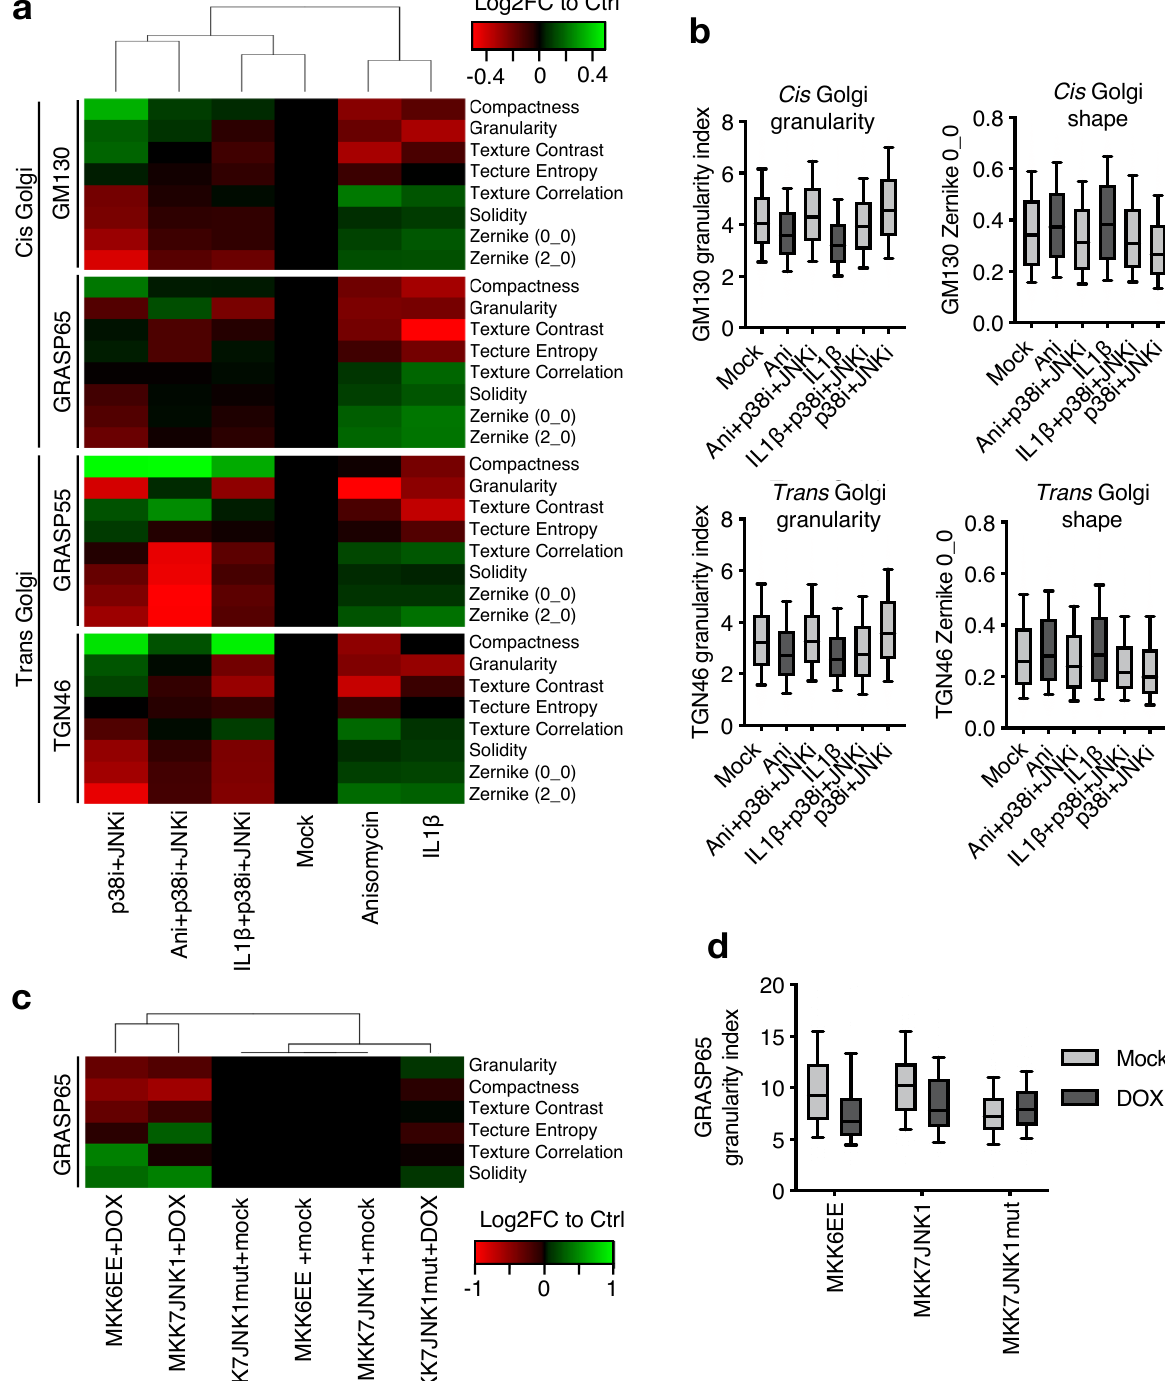
Figure 5. Regulation of Golgi morphology by p38 and JNK. ( a ). Heatmap and horizontal clustering of descriptors of Golgi morphology. U2OS cells were pre-treated with the combination of JNK and p38 inhibitors (JNKi, p38i, 0.5 h) and treated with anisomycin (Ani, 1 h) or IL1 β (1 h) as indicated. Cells were fixed, immunostained with antibodies against cis Golgi markers GM130, GRASP65 and/or trans Golgi markers GRASP55 and TGN46 and images were acquired by high content microscopy. Images were processed and analyzed with CellProfiler software for calculation of the indicated parameters, and are presented as log2-transformed mean fold changes compared to the control. n > 1700 cells. ( b ). Box plots of